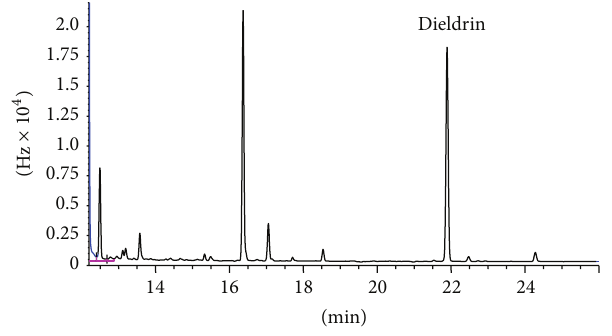
Figure 7: Terminalia sericea (B) after HS-SPME-GC-ECD analysis.